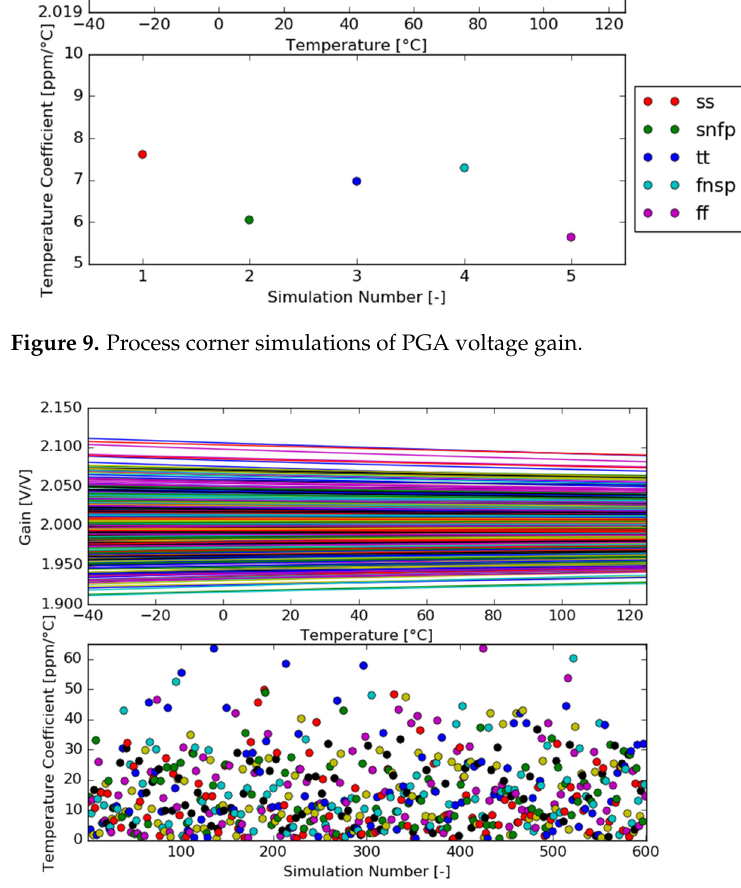
Figure 10. Monte Carlo simulations of PGA voltage gain.